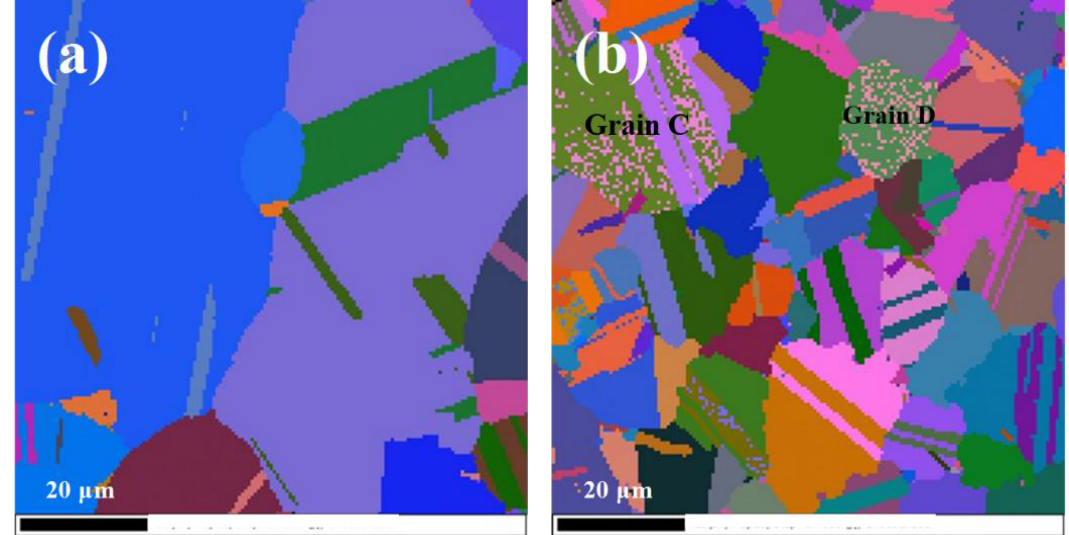
Figure 4. Euler map after hot deformation at 1150 ◦ C to a strain of ( a ) 0.5 and ( b ) cooling to 1000 ◦ C with cooling rate of 6 ◦ C /min.